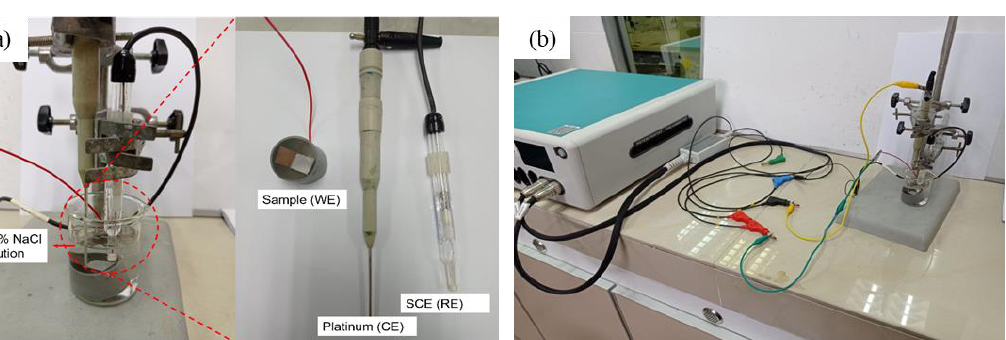
Figure 4. ( a ) Three-electrode electrochemical cell arrangement in the experiment with the pictures of the working electrode, counter electrode and reference electrode. ( b ) The full setup connection of the potentiodynamic polarisation testing.